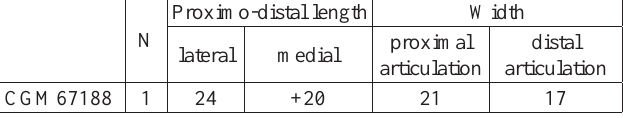
Table 2. Dimensions (in mm) of a hyracoid astragalus, cf. Antilohyrax sp. from the BOTM at Minqar Tibaghbagh, Qattara Depression, Egypt. Abbreviations: N, number of specimens; +, indicates dimensions of the fossil were originally greater (damaged specimen).